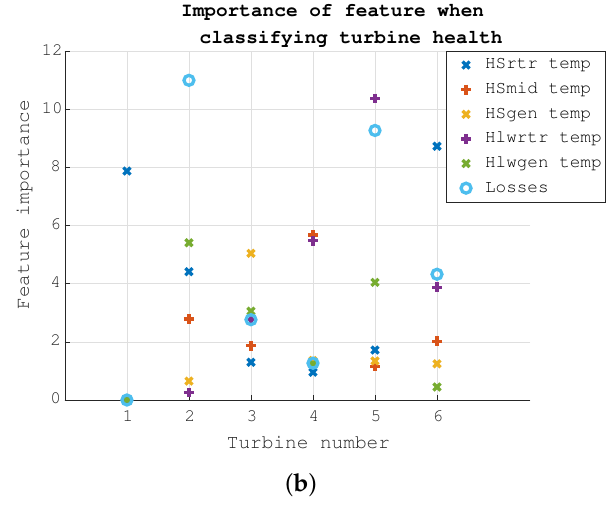
Figure 12. PFI results including thermal network modelling